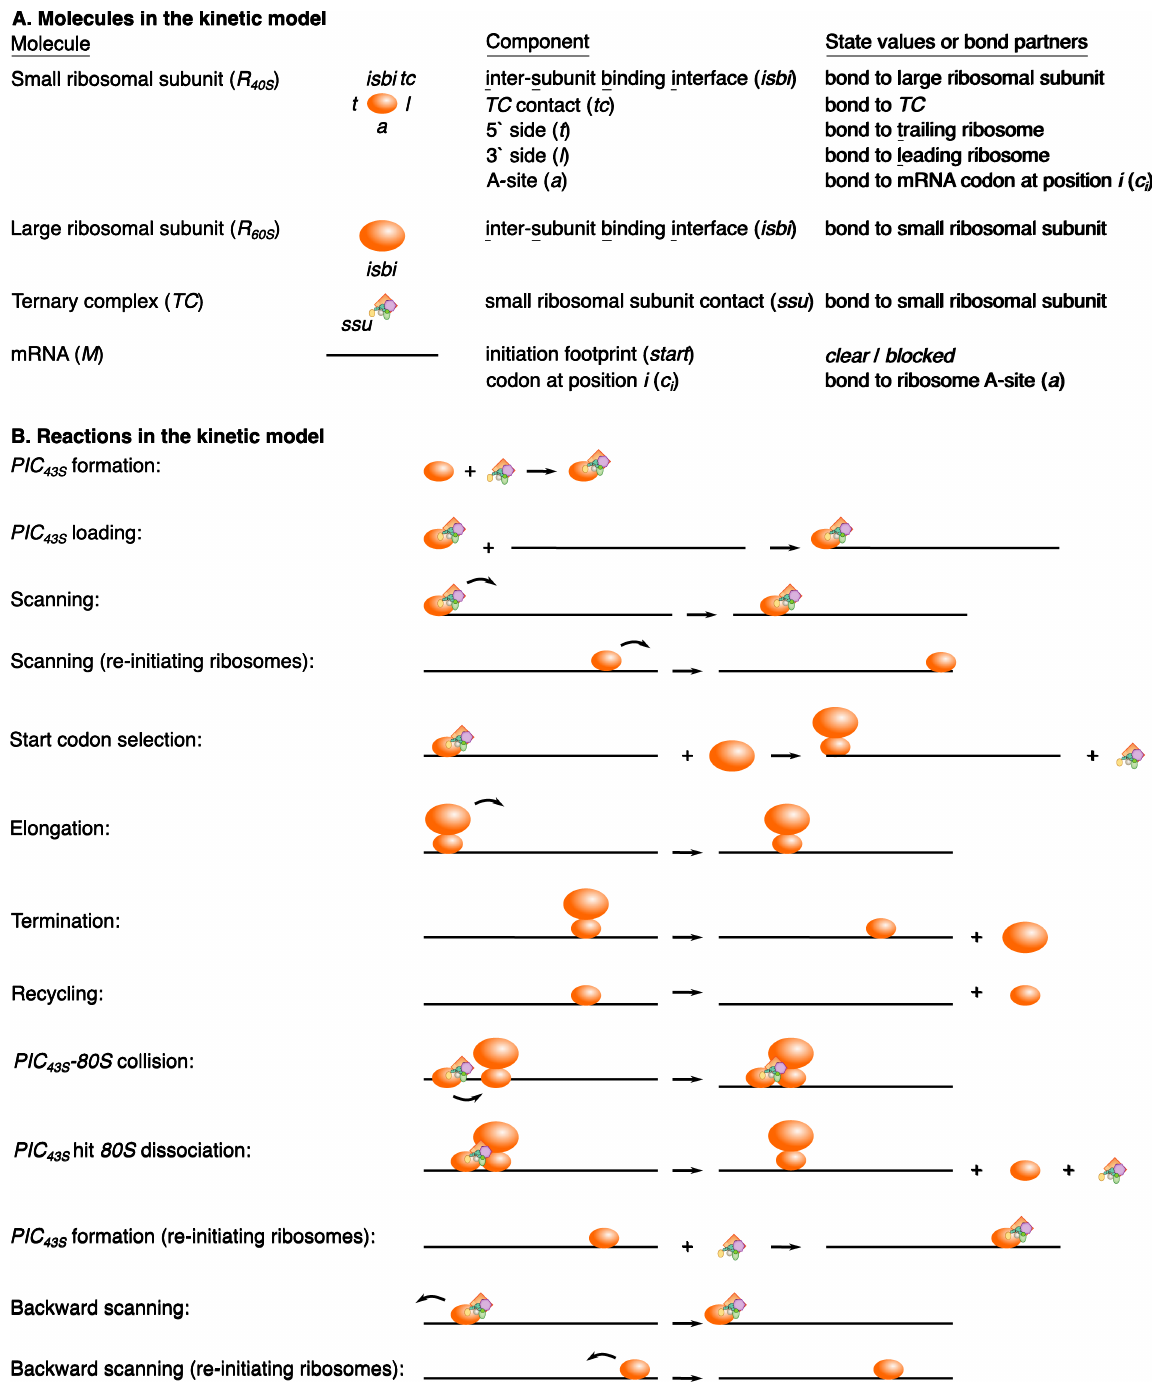
Fig 3. Modeling workflow. (A) Molecules in the kinetic model. Molecules have components each of which has state values or binding sites for other molecules (called bond in BioNetGen). Components are abbreviated in parentheses by how they are referenced in the model specification. For example, the mRNA ( M ) initiation footprint ( c to c where n is equal to the ribosome footprint size in nt) can either be clear of ribosomes, 1 n and therefore free for a PIC 43S loading reaction to occur, or blocked by a ribosome, preventing this reaction. (B) Visual representations of the formation ( R binding TC ) can occur if the R is reactions in the kinetic model. Re-initiation necessitates several additional reactions. PIC 43S 40S 40S bound to the mRNA; this TC re-binding is required for start codon selection competence. R 40S molecules can scan forward or backward. Some reactions in the kinetic model, such as different types of collision and dissociation reactions, are not depicted here.